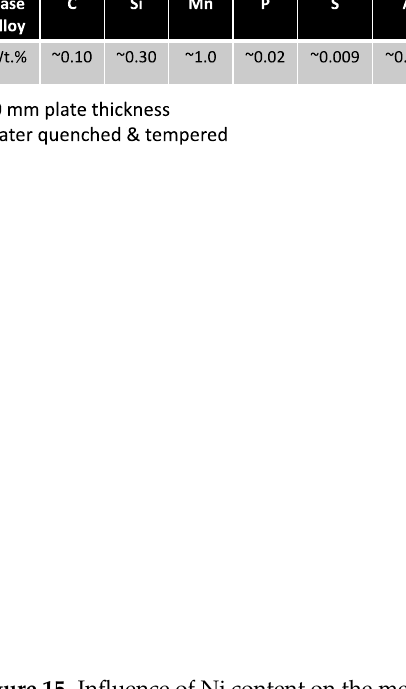
Figure 15. Influence of Ni content on the mechanical properties of cryogenic steels.